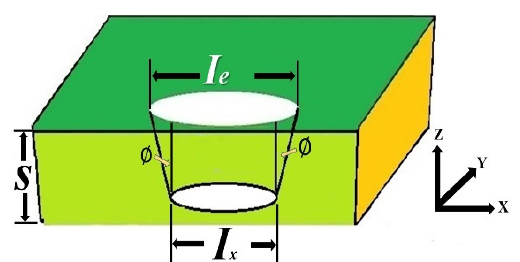
Figure 4. Schematic of average taper ( T tap ) of a drilled hole.